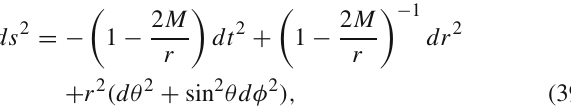
Fig. 15 The full visual diagram of wormhole